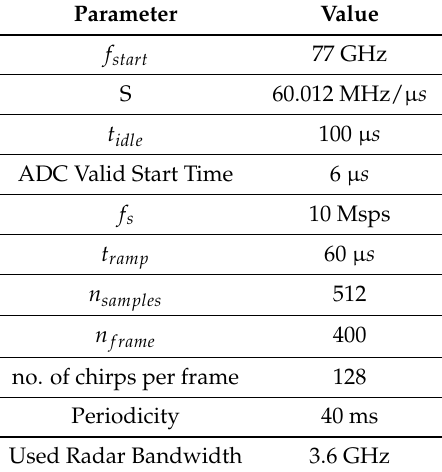
Table 1. RADAR parameters.